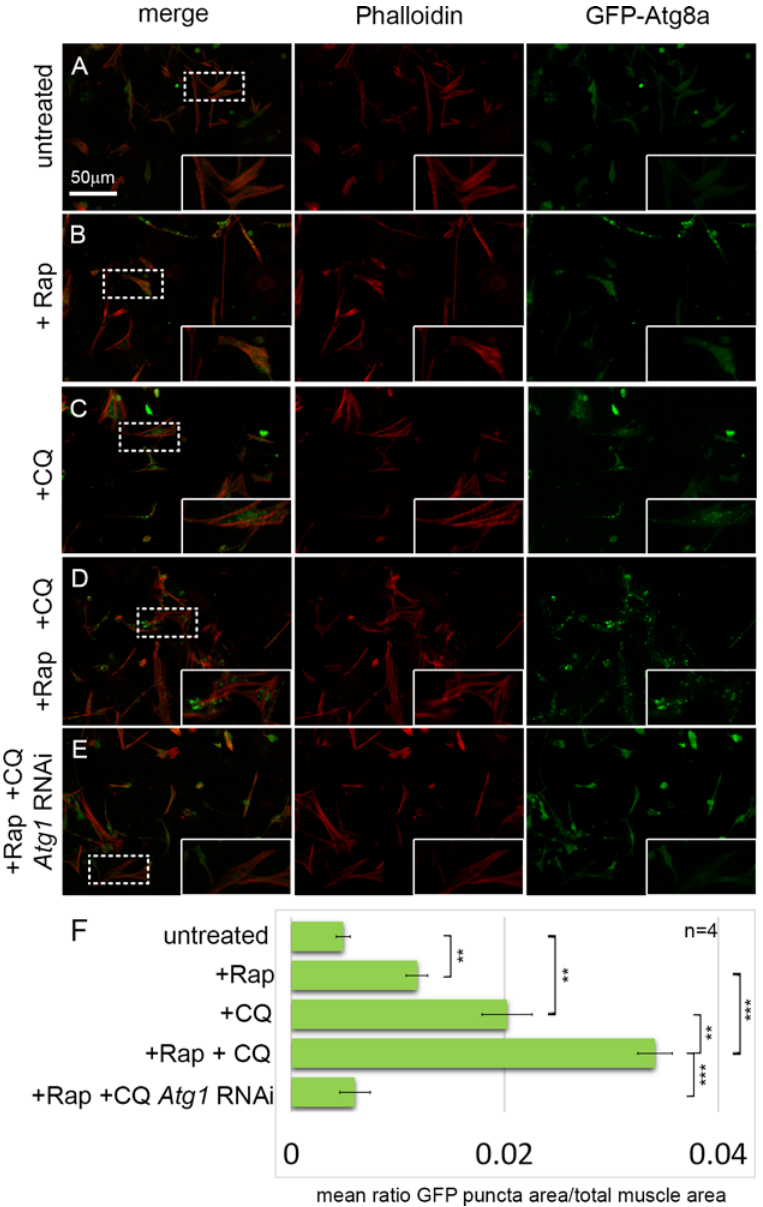
Fig 1. An assay for monitoring autophagy levels in primary cultured muscles. (A-D) Primary cultures from D. melanogaster embryos expressing GFP-Atg8a under the control of Dmef2-Gal4 , stained with Phalloidin (actin) in red. Inset are magnifications of areas denoted by dotted line. (A) In untreated control cultures, GFP-Atg8a localizes throughout the muscle cytoplasm and nuclei. (B) Addition of rapamycin (Rap) for 12 hrs results in the formation of small GFP-Atg8a labeled punctae. (C) Addition of chloroquine (CQ) for 12 hrs results in the accumulation of large GFP-Atg8a labeled vesicles that localize around the nucleus and between the myofibers. (D) Addition of both CQ and Rap for 12hrs, triggers the formation of greater numbers of enlarged vesicles in the muscles than either drug alone. (E) Knockdown of the core autophagy gene, Atg1 , prevents the formation of GFP-Atg8a vesicles in CQ+Rap treated cultures. (F) Quantification of the mean ratio of GFP-Atg8a punctae area to total muscle area per well (n = 4). Error bars indicate SEM with ** p < .01; *** p <